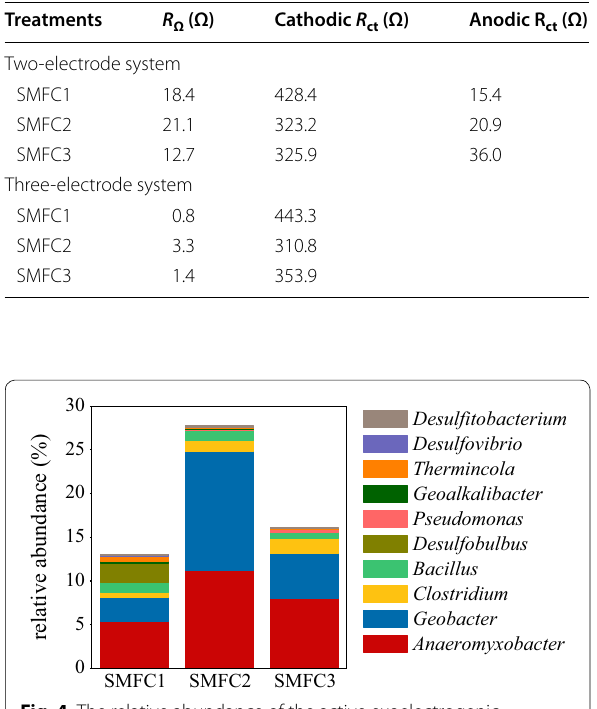
Figure S2. An equivalent circuit that comprised two resistor–capacitor parallel circuits and an ohmic resist- ance was applied to fit the impedance data obtained from the two-electrode system (Additional file 1: Figure